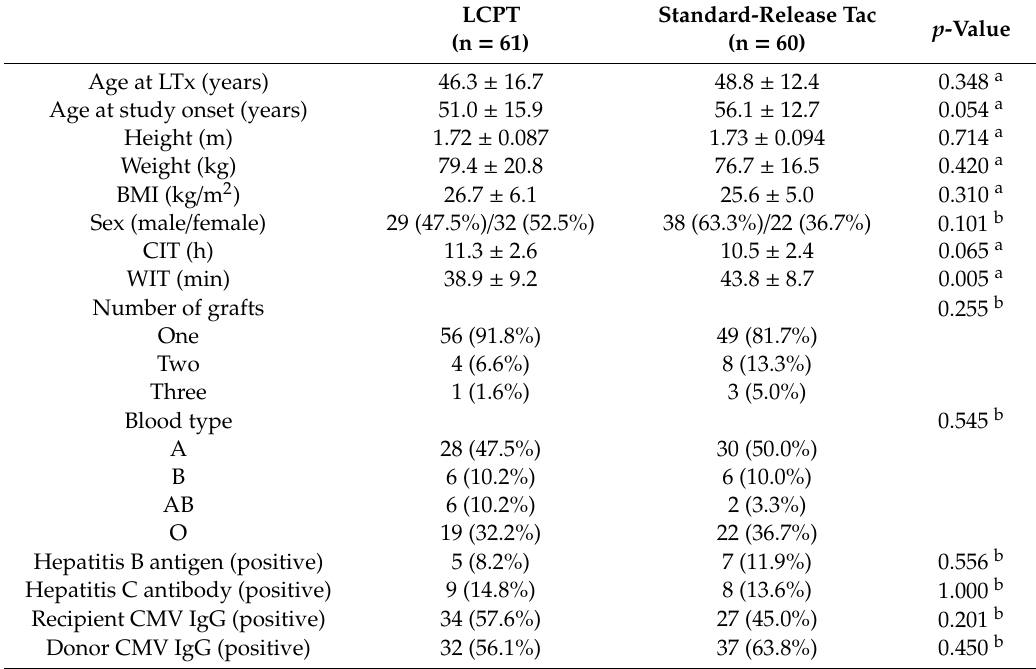
Table 1. Patient